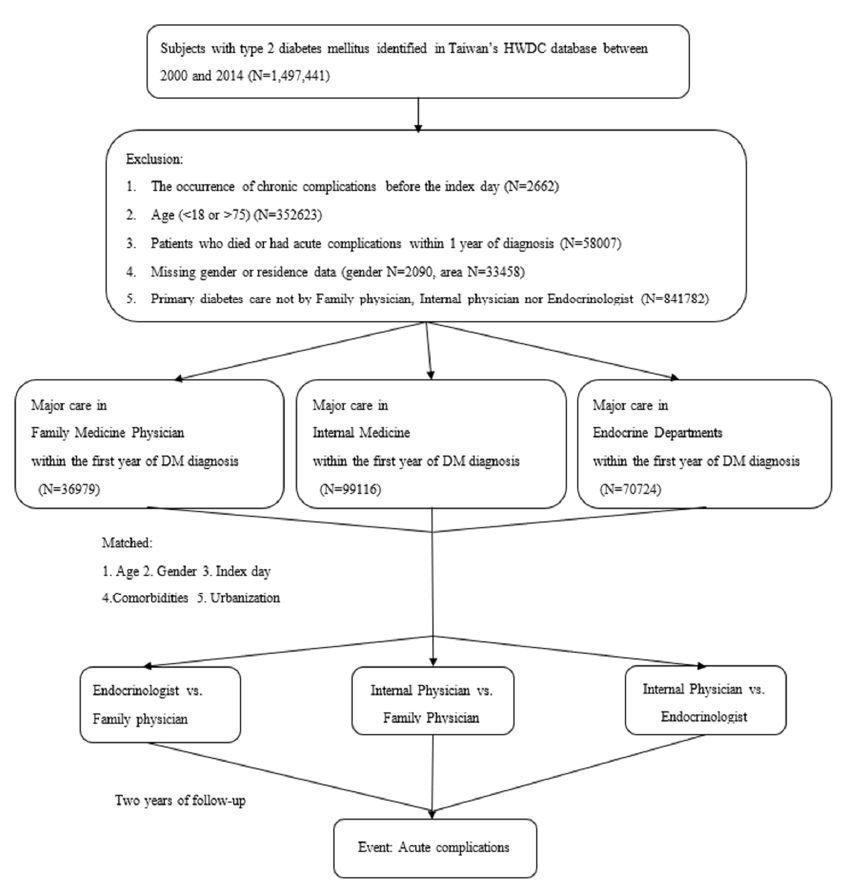
Figure 1. Study flow. Enrollment, distribution of each stage, and the end of the follow-up process for study eligible participants in the Health and Welfare Data Science Center (HWDC). After matching, the FM and IM cohorts (28,269 vs. 28,269) had similar ages and overall comorbidities, but the IM cohort had a higher initial prescription of insulin by 0.15 times/month and a higher annual diabetes-related cost of USD 20. Furthermore, participants in the FM cohort received a slightly higher testing frequency for HbA1c and lipid profiles annually. On the other hand, those in the IM cohort had a higher testing frequency for ACR annually (Table 1). Table 1. Characteristics of the family medicine (FM) and other internal medicine (IM) cohorts a . FM n = 28,269